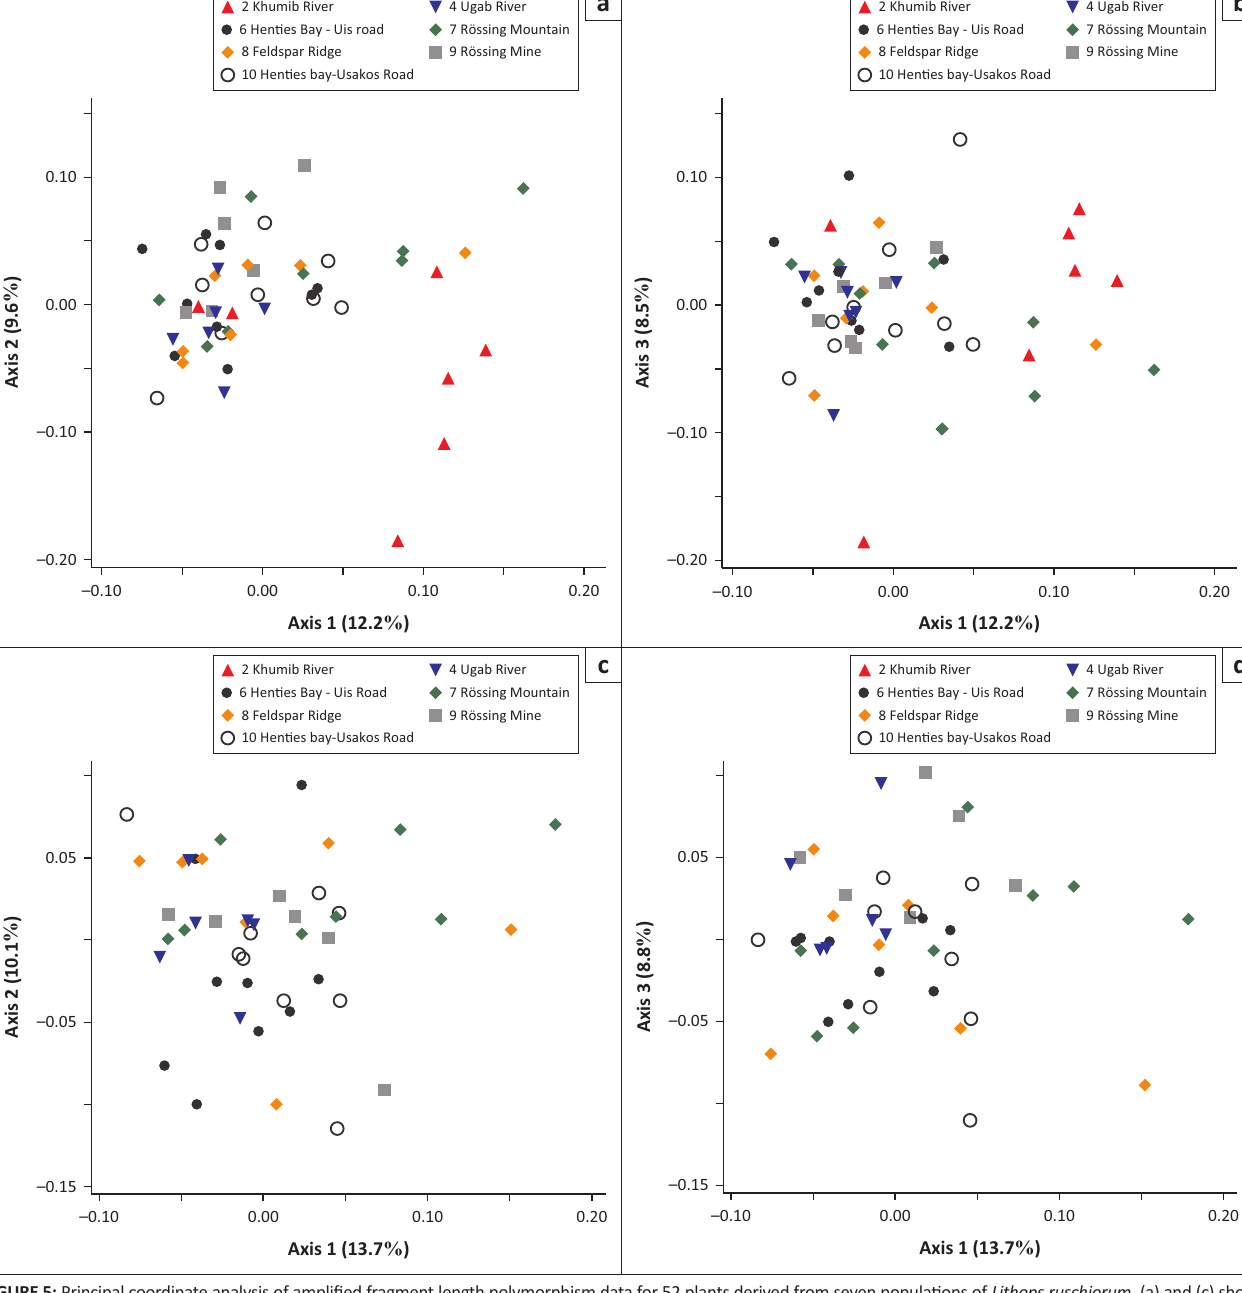
FIGURE 5: Principal coordinate analysis of amplified fragment length polymorphism data for 52 plants derived from seven populations of Lithops ruschiorum. (a) and (c) show dimensions 1 and 2, while (b) and (d) show dimensions 1 and 3. (a) and (b) include all populations, whereas (c) and (d) exclude the somewhat deviating population Khumib